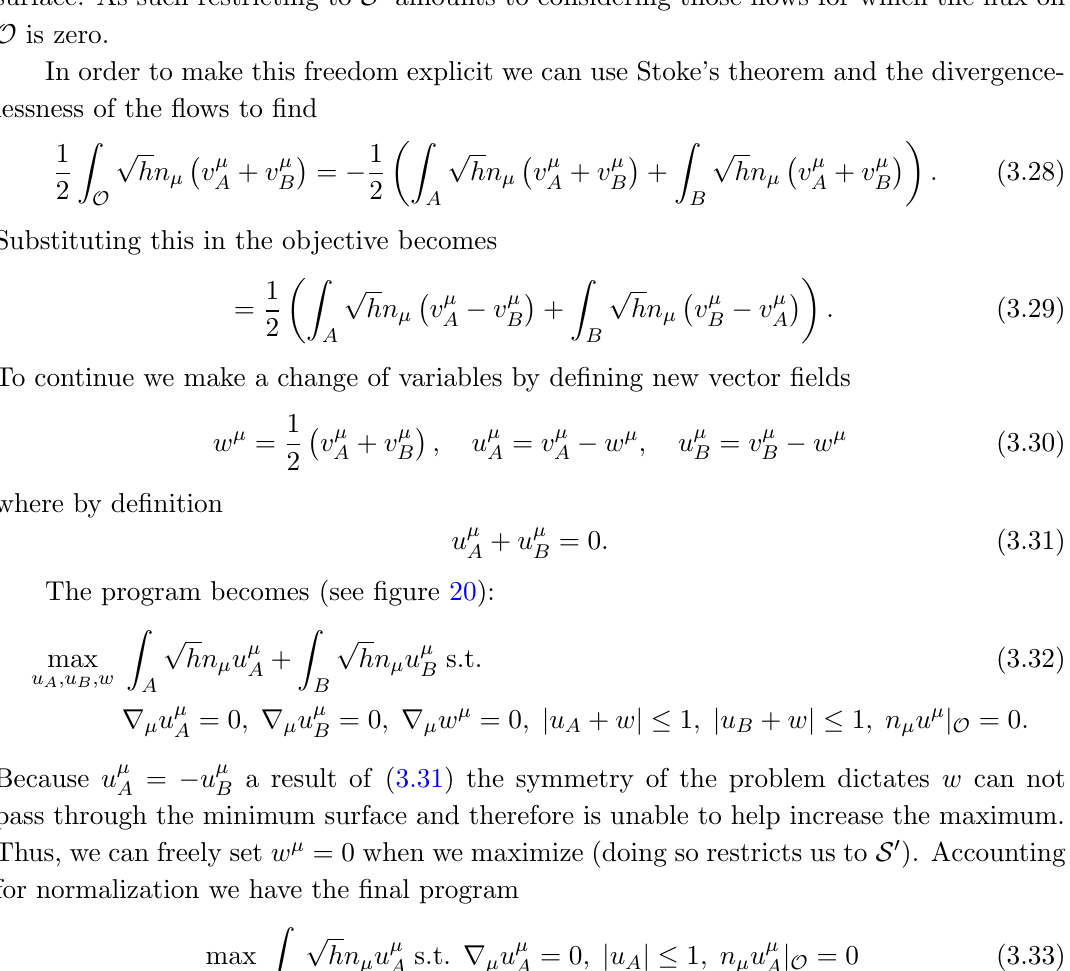
A and v B . Such (cid:13)ows are not in S 0